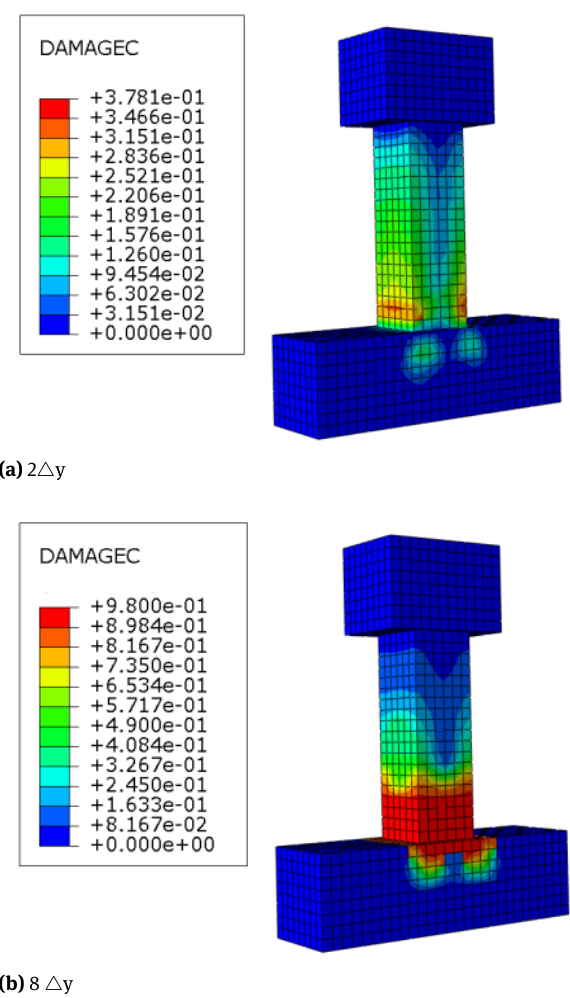
Figure 15: Nephograms of Compression Damage of C5